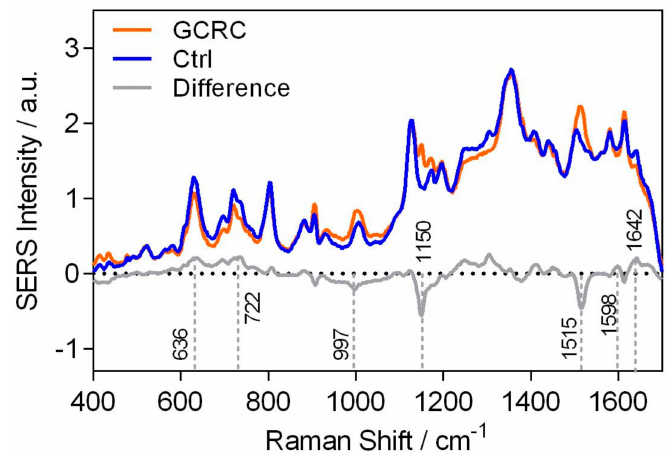
Figure 2. Mean serum surface-enhanced Raman scattering (SERS) spectra of the control group (Ctrl), of the gastric and colorectal cancer (GCRC) group, and their di ff erence spectrum. The SERS spectra of serum were acquired from 53 patients in the GCRC group and 25 control subjects in the Ctrl group.